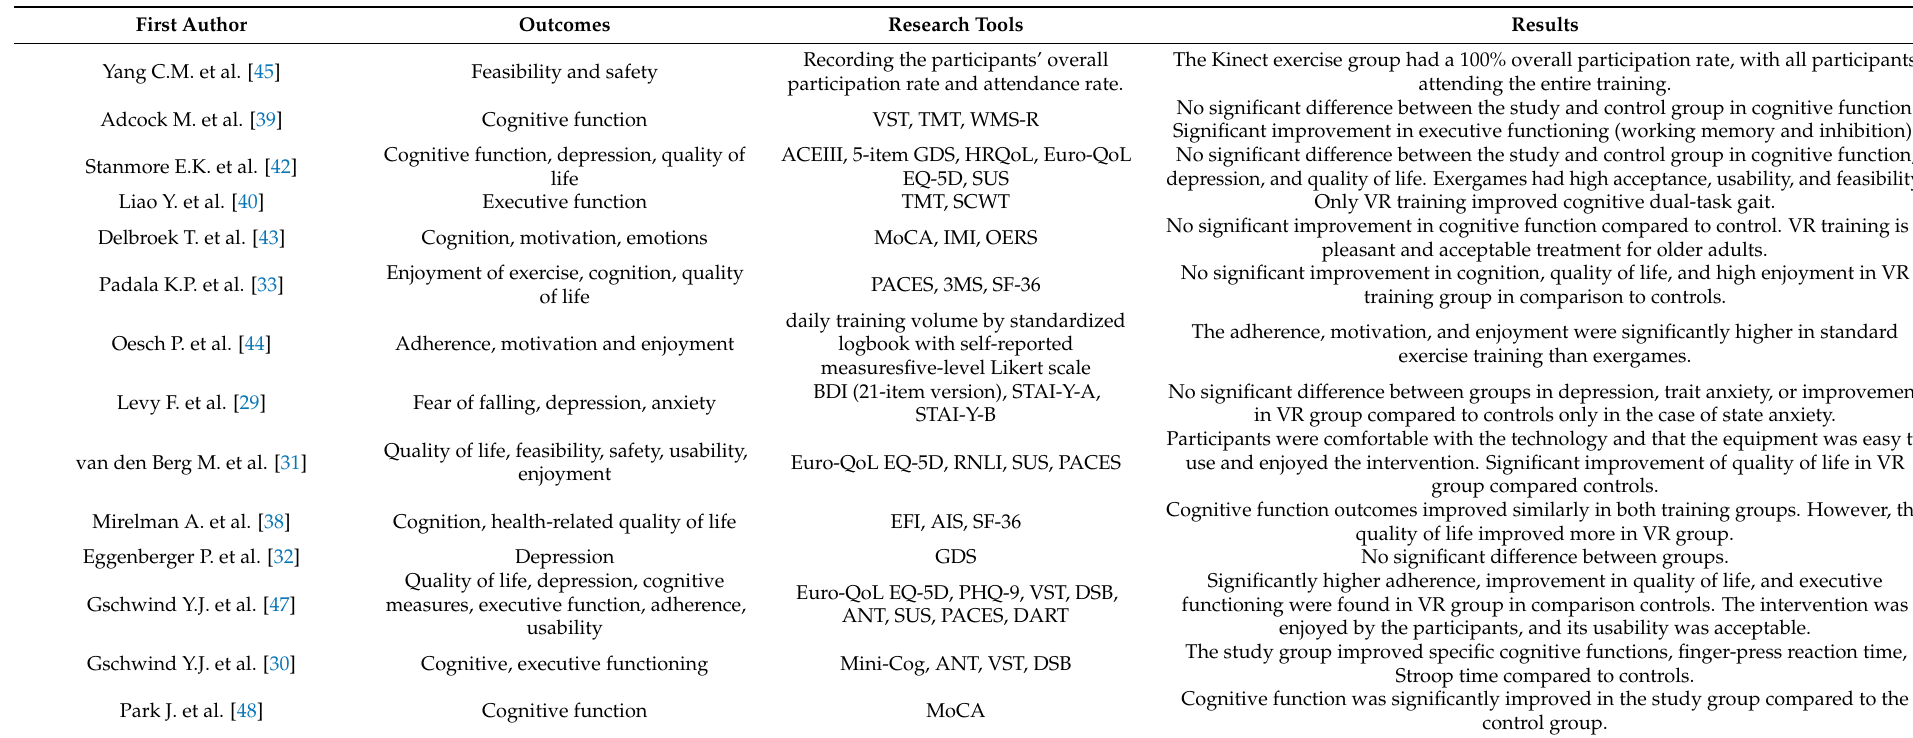
Table 3. Qualitative